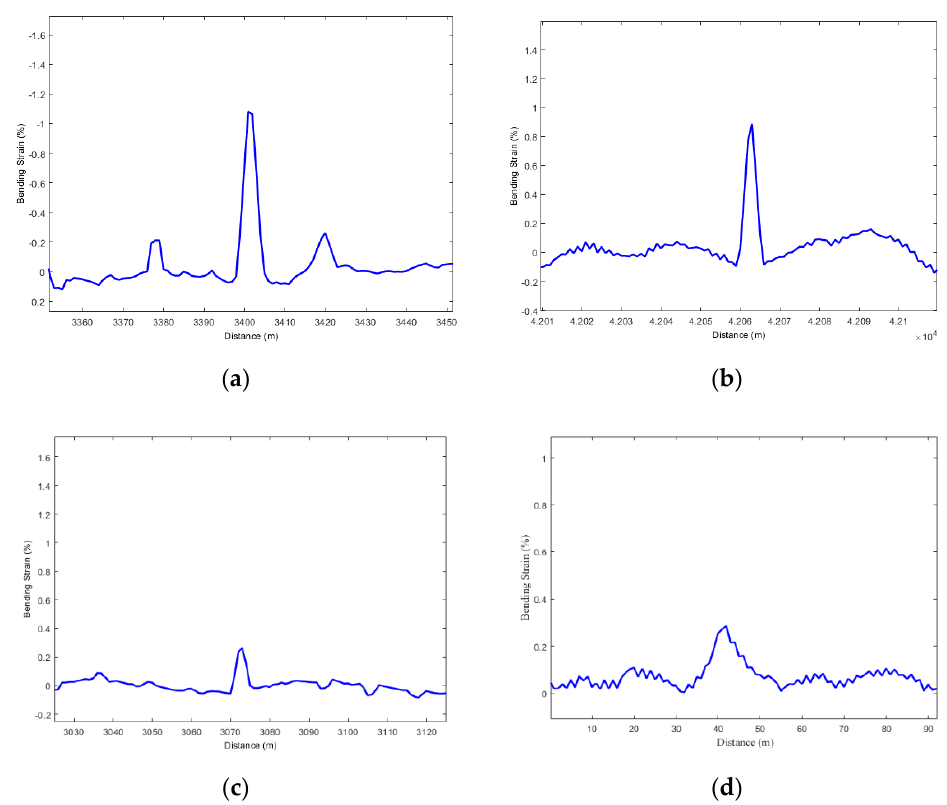
Figure 3. Pipeline features based on the bending strain. ( a ) Dent; ( b ) bend; ( c ) girth weld anomaly; ( d ) displacement and bending section.